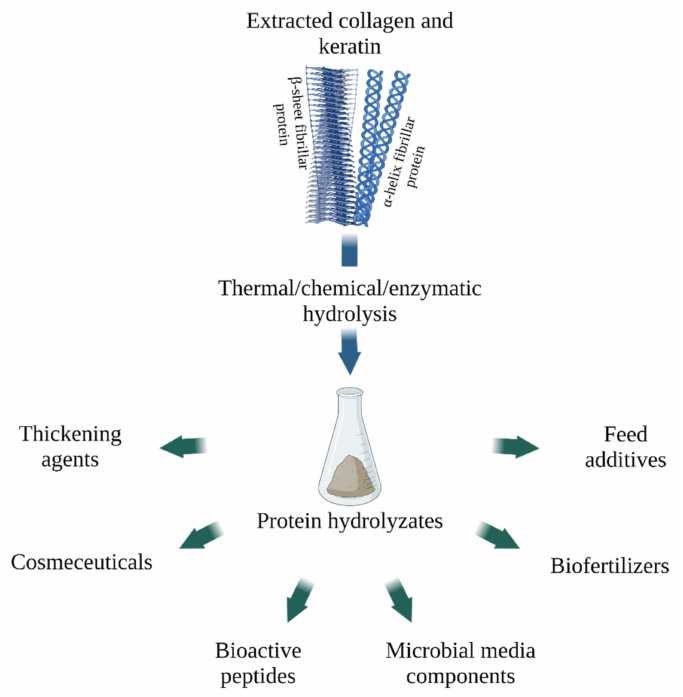
Figure 5. Applications of collagen and keratin hydrolysates (created with BioRender.com, access date: 9 November